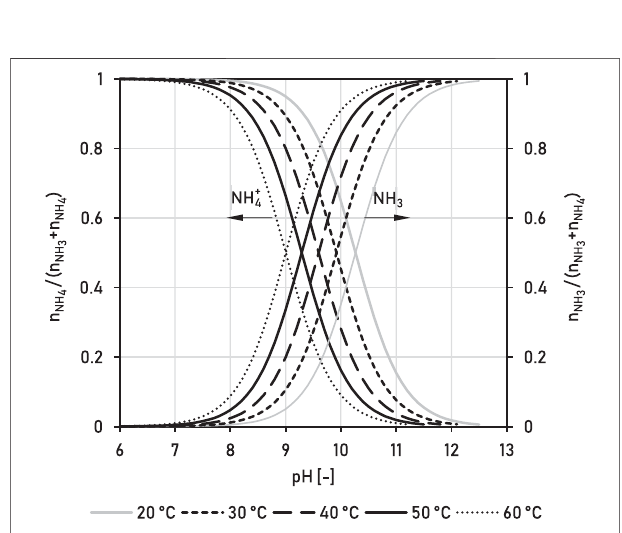
FIGURE 2 | Effect of temperature and pH on the distribution of NH + 4 and NH 3 in human